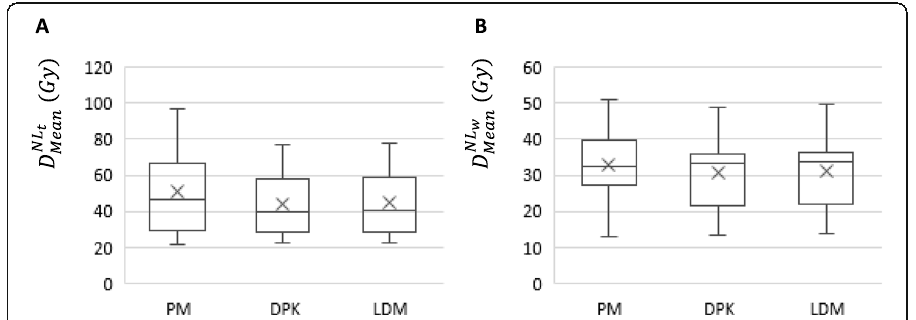
Fig. 2 Mean absorbed doses delivered to target normal liver a and whole normal liver b volumes, determined by means of PM and both 3D voxel dosimetry methods (LDM and